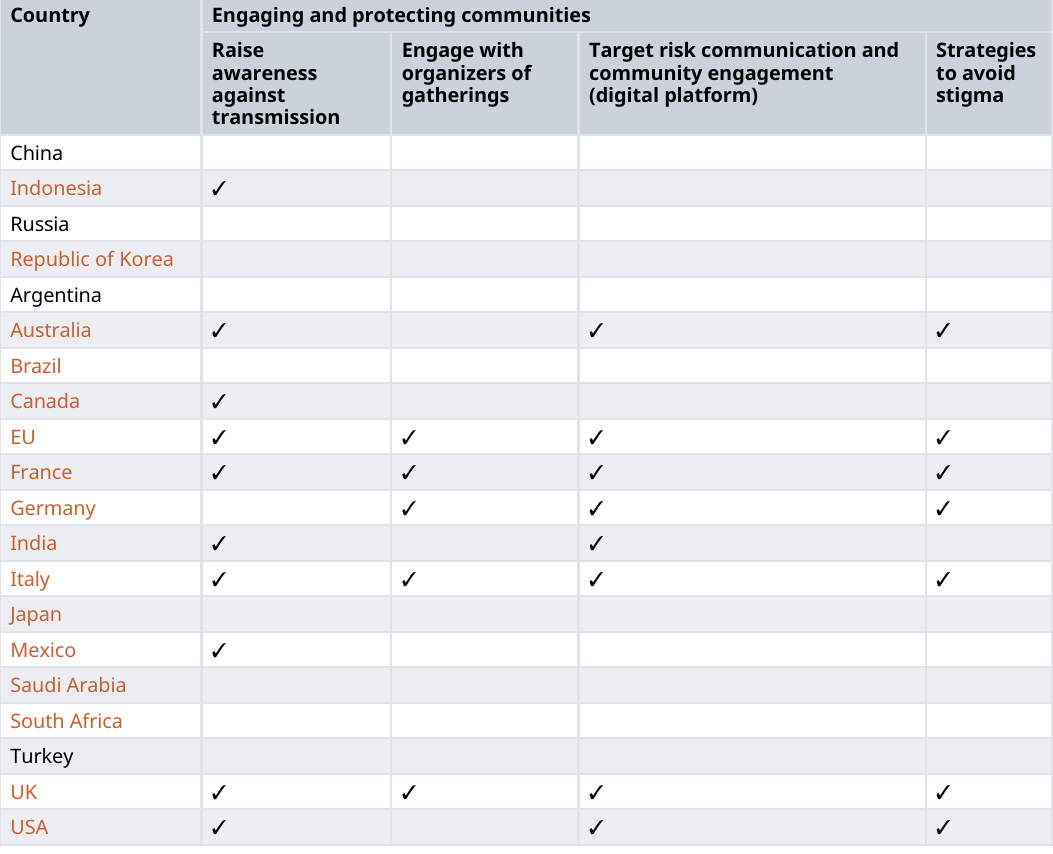
Table 3. Engaging and protecting communities. Country Engaging and protecting